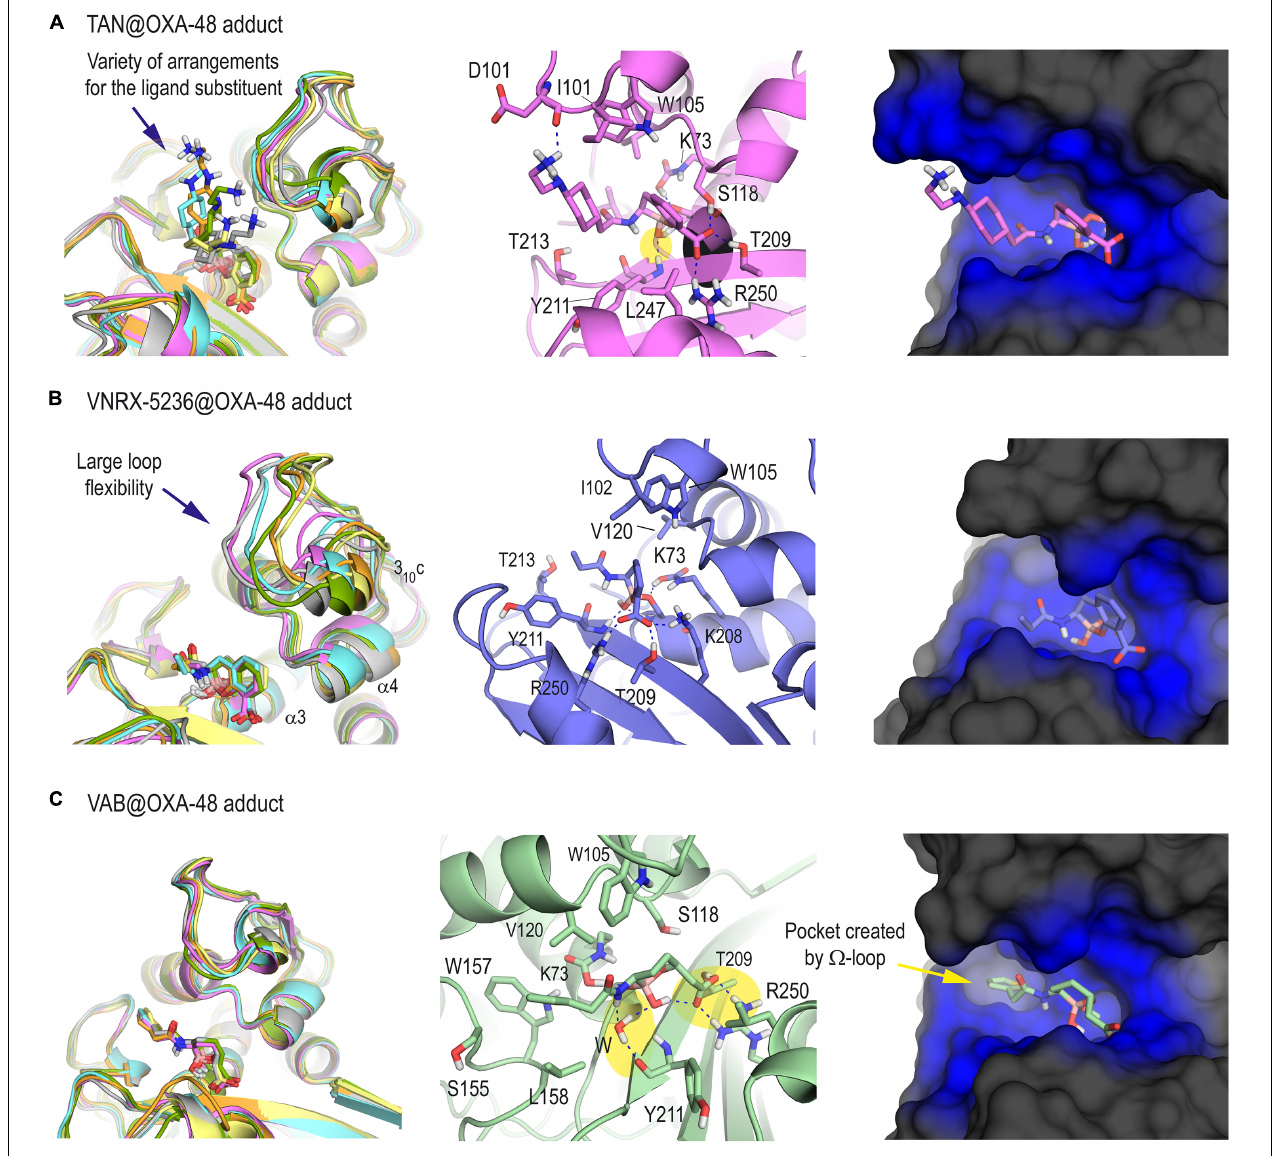
FIGURE 3 | 3D structure of OXA-48 enzyme inactivated by taniborbactam (A) , VNRX-5636 (B) , and vaborbactam (C) obtained by MD simulation studies. For each panel, the superposition of several snapshots from the 100 ns of simulation, the interactions of the modified ligand and the overall overview are shown. For the latter case, snapshots taken after 90 ns of simulation are shown. Note the large variety of arrangements of the amide moiety of the modified taniborbactam, as well as the weak interaction of the active site-covering loop involving helix 3 10 c with the modified VNRX-5236. See how the boronate moiety of the modified vaborbactam is anchored in the active site via a water molecule, while for all the bicycle boronate derivatives studied herein direct contacts with main carbonyl group of Y211 are observed (yellow shadow). Relevant side chain residues are shown and labeled. Key hydrogen bonding and electrostatic interactions are shown as blue dashed lines. The enzyme area surrounding the adduct is highlighted in